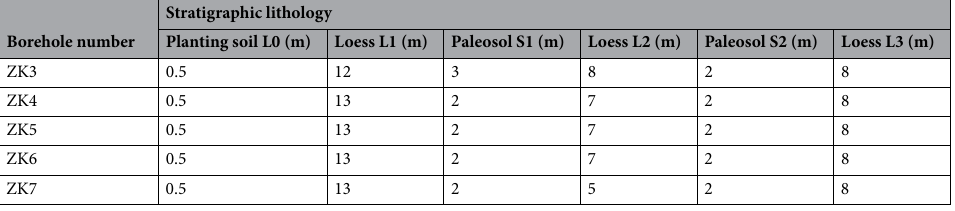
Table 1. Borehole lithology and stratification.